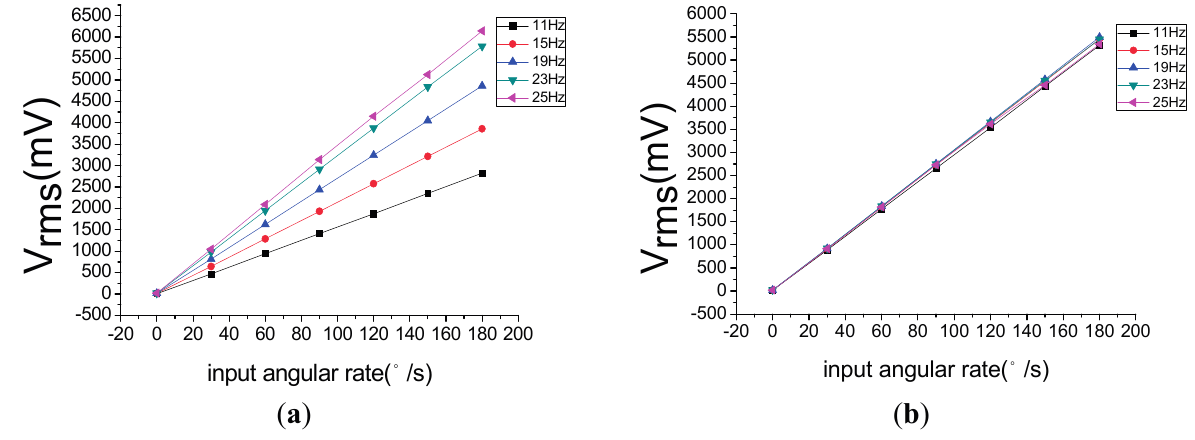
Figure 14. ( a ) The change before compensation; ( b ) the change after